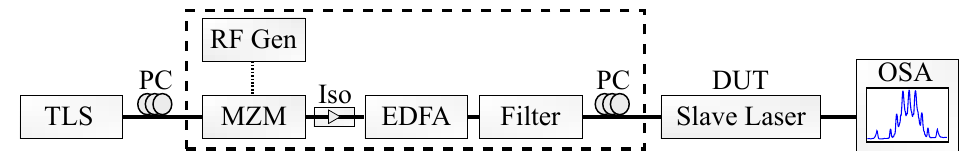
Figure 3. Setup used to measure the intensity plots of the optical injection locking experiments. Dashed lines indicate the additional setup used when injecting optical combs. TLS: tunable laser source, MZM: